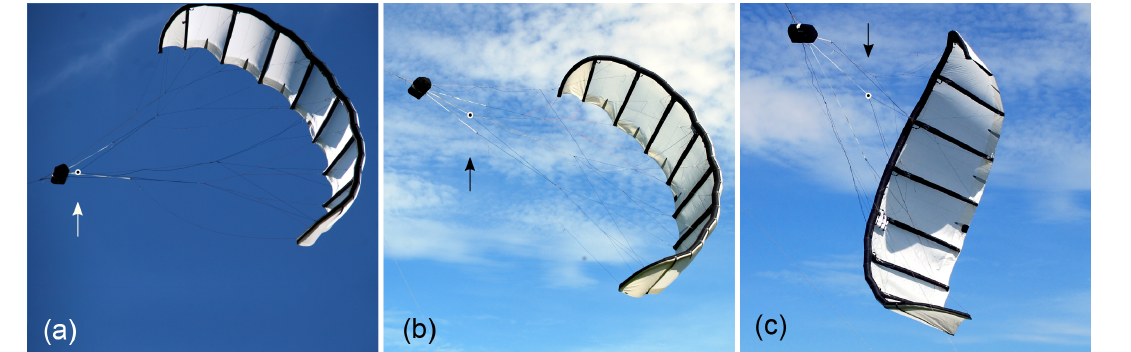
Figure 4. An almost fully powered LEI V3 kite ( a ), a depowered kite ( b ) and deformation of the wing by extreme steering input in depowered state ( c ). Dots indicate the end of the depower